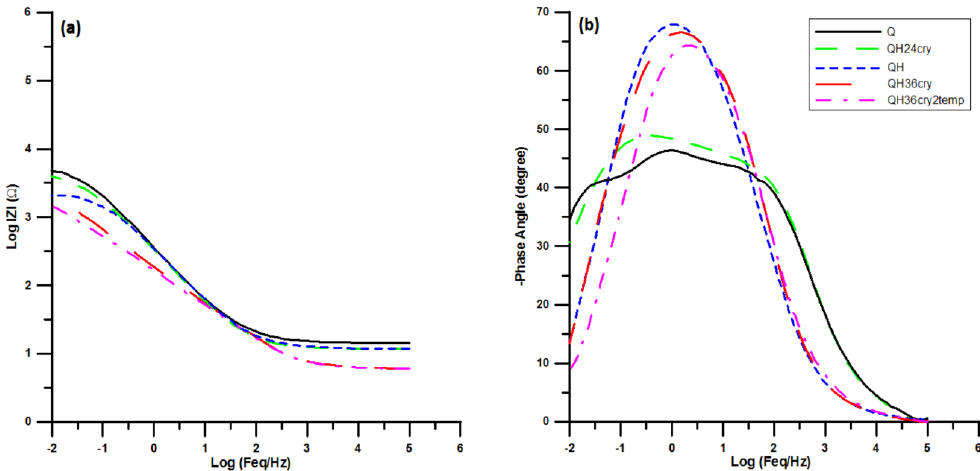
Figure 3. EIS data represented by Bode (a) and phase angle (b) variation vs. log frequency diagrams for different pre-treated AISI D3 steel samples in 3.5% NaCl